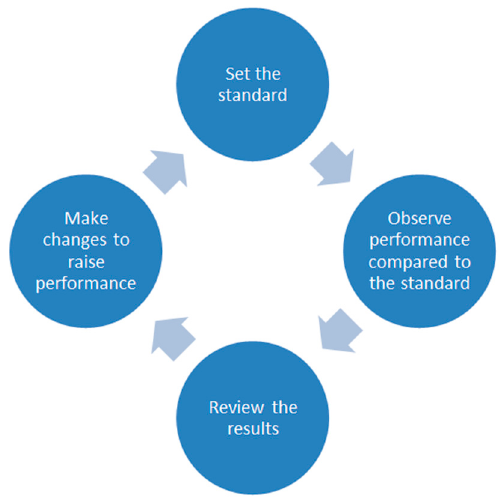
Figure 1. The audit cycle.